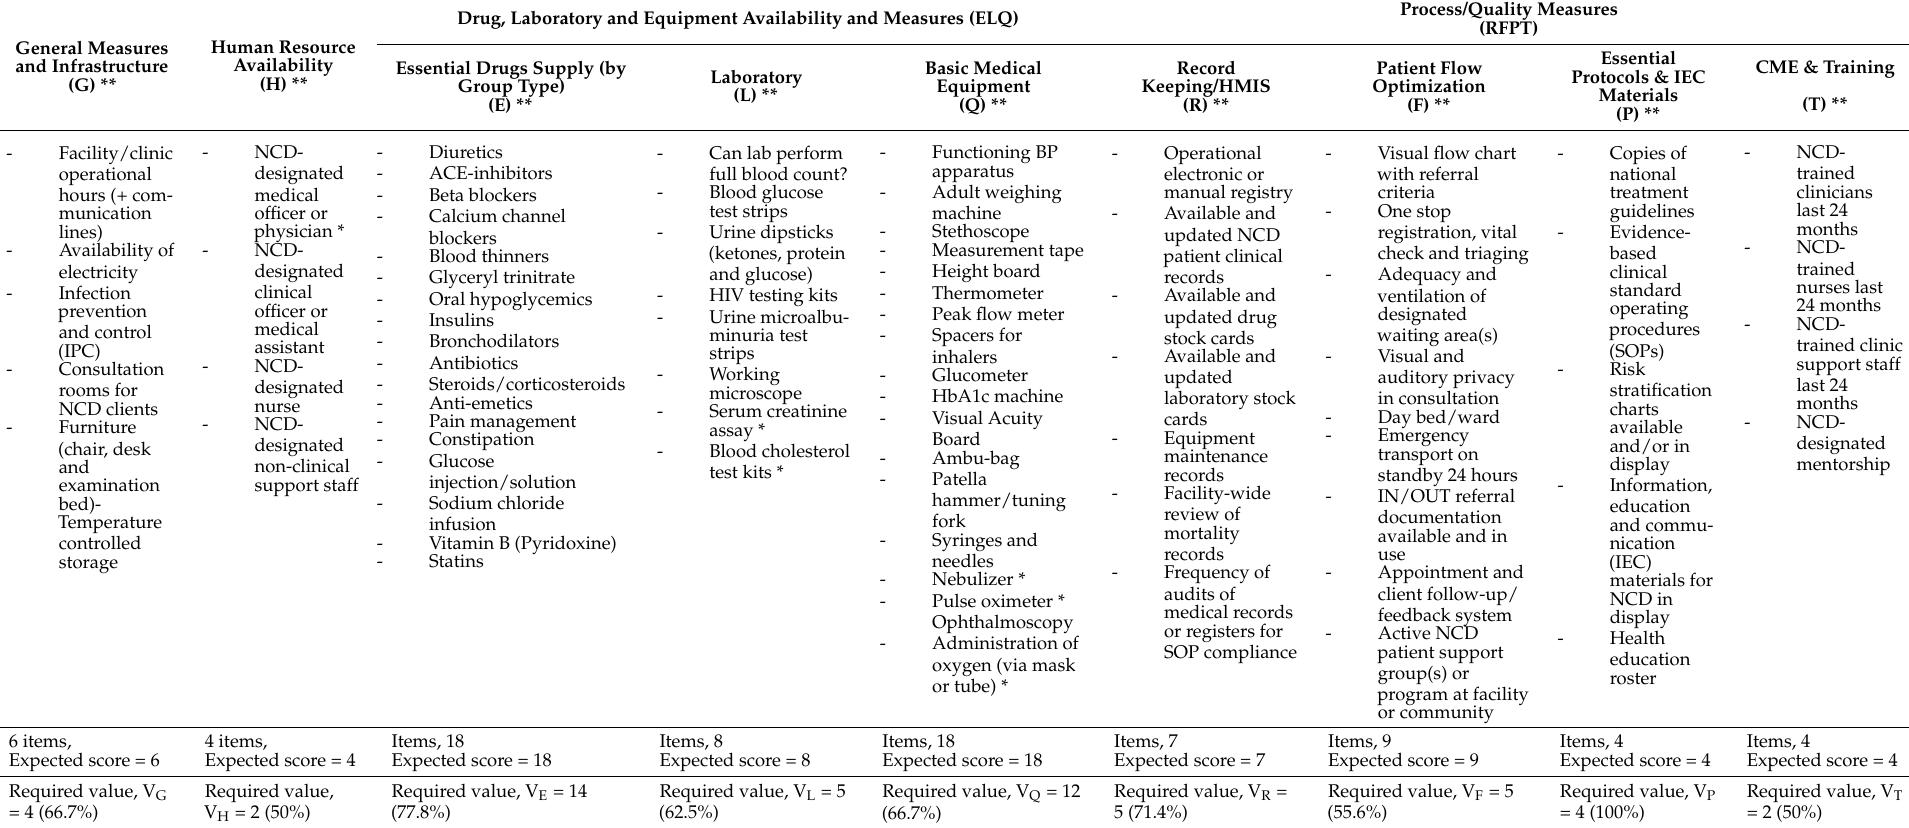
Table A1. Facility Capacity and Preparedness Assessment